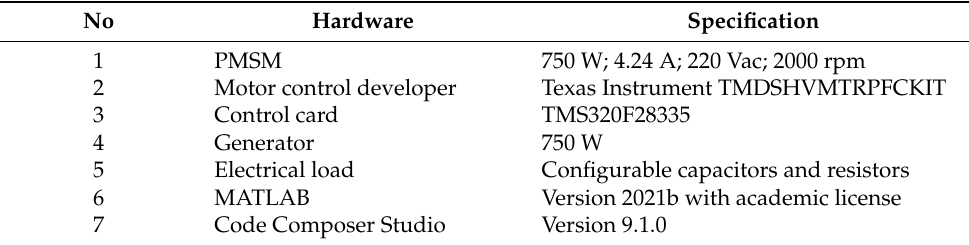
Figure 16. Experimental hardware realization. Table 4. Experimental hardware tools and devices.